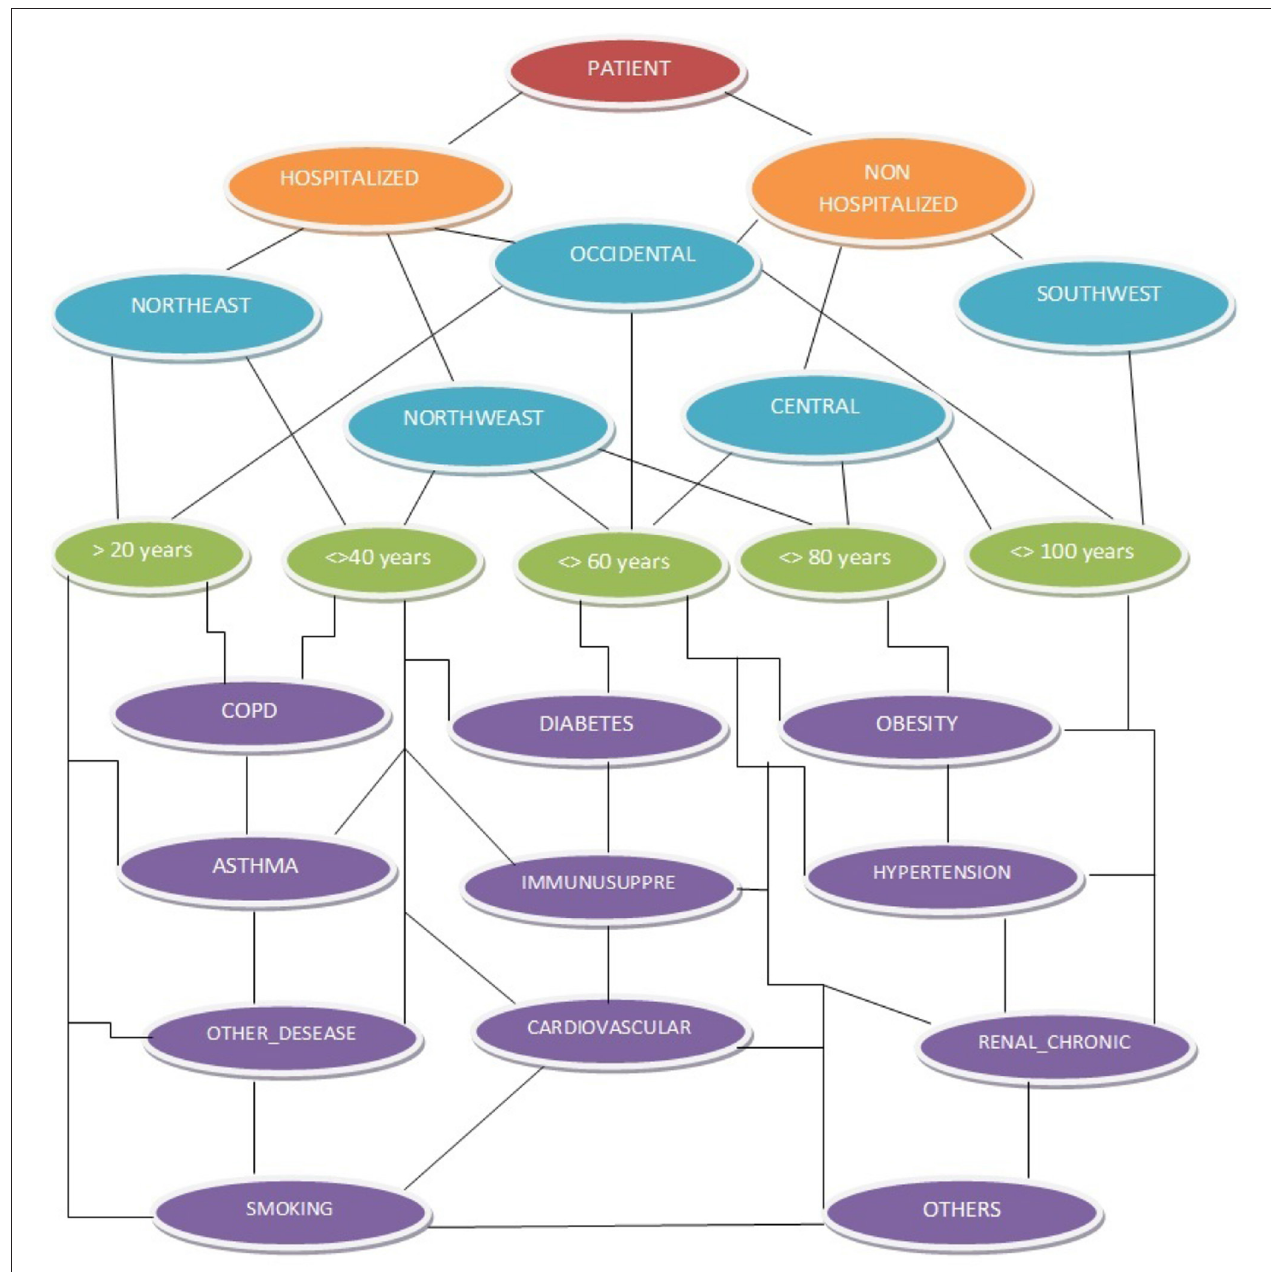
FIGURE 1 | A network database was constructed with hierarchical variables, with the hierarchy level identified by 5 different colors: maroon, orange, blue, green, and purple.